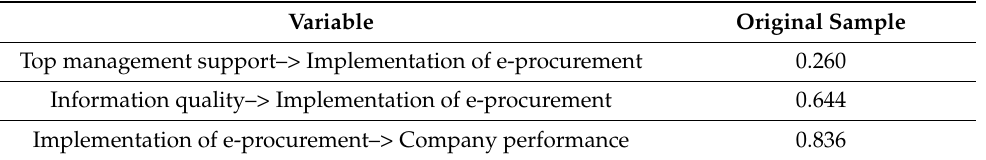
Table 9. Results of path coefficient